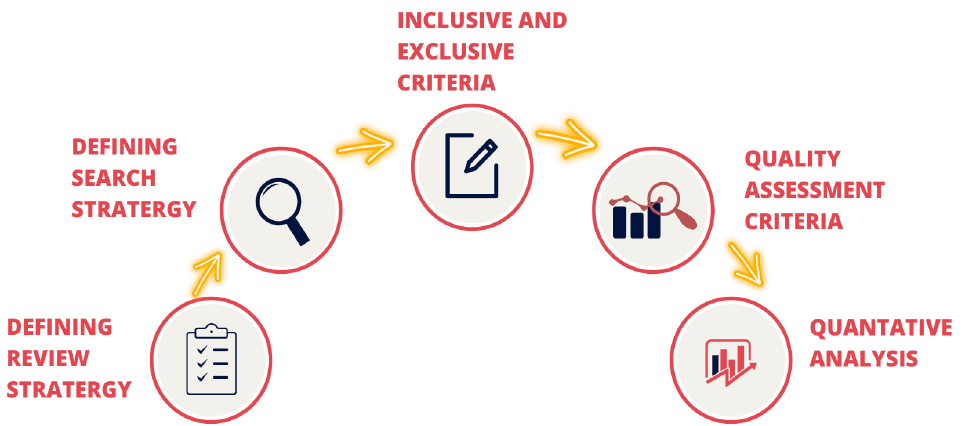
Figure 2. SLR protocol